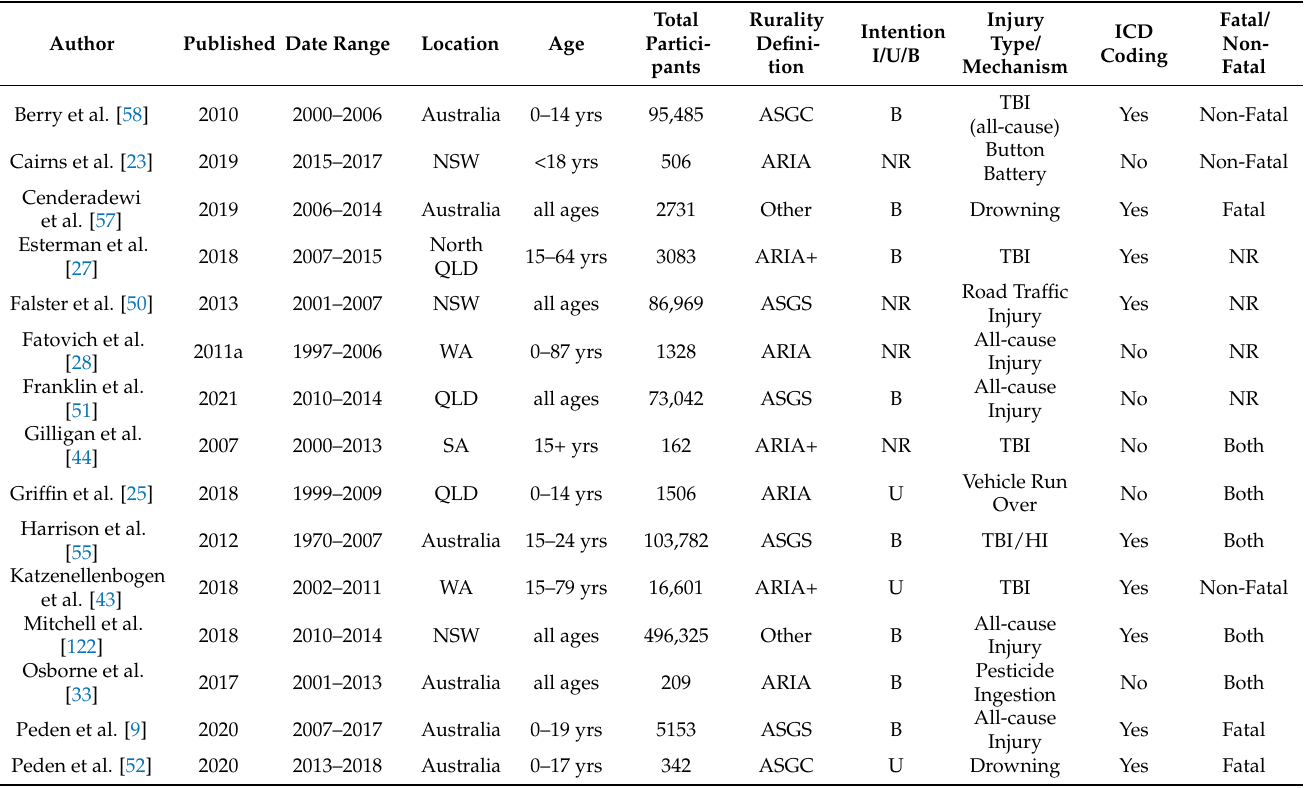
Table 3. Rural Australia Studies by ASGS Classification (included studies).